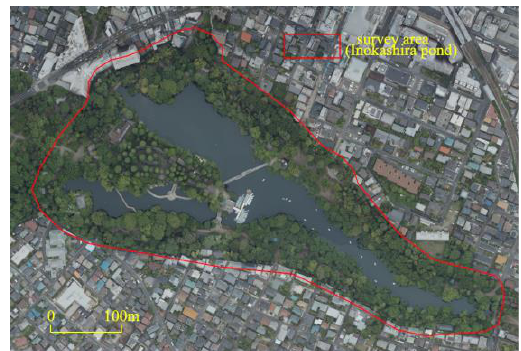
Figure1. Study area of Inokashira Pond as a natural pond